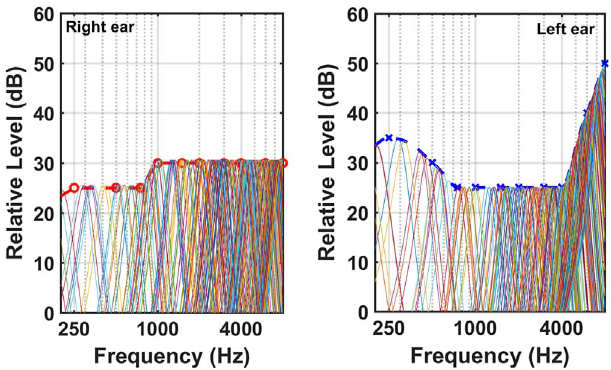
Figure 8. Log-spectra of the right and left fi ltered broadband stimuli superimposed to the HL